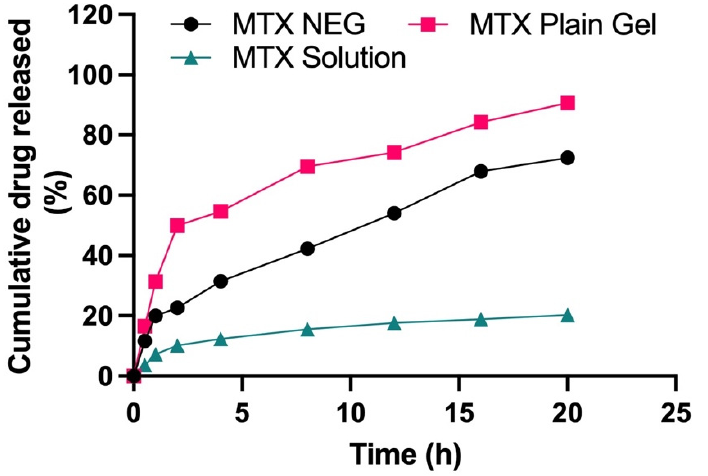
Figure 3. Cumulative % age drug release from MTX solution, MTX plain gel, and optimized MTX